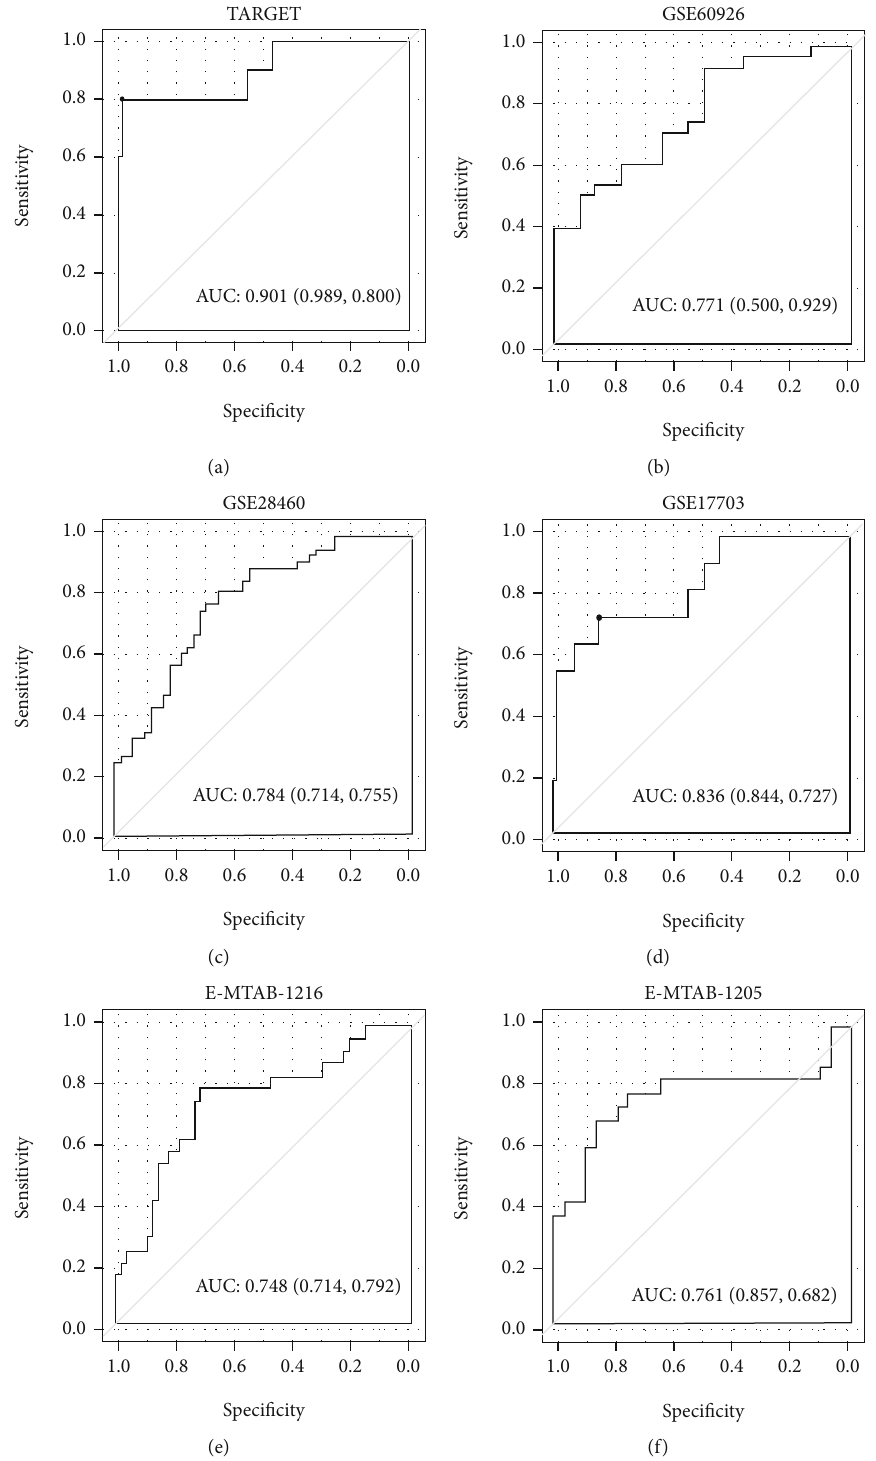
Figure 6: The predictive performance of the seven-lncRNA-mRNA signature for recurrence outcomes in di ff erent datasets: (a) ROC curve of TARGET; (b) receiver operator characteristic curve of GSE60926; (c) ROC of GSE28460; (d) ROC curve of GSE17703; (e) ROC curve of E- MTAB-1216; (f) ROC curve of E-MTAB-1205. ROC: receiver operating characteristic curve; AUC: area under the ROC